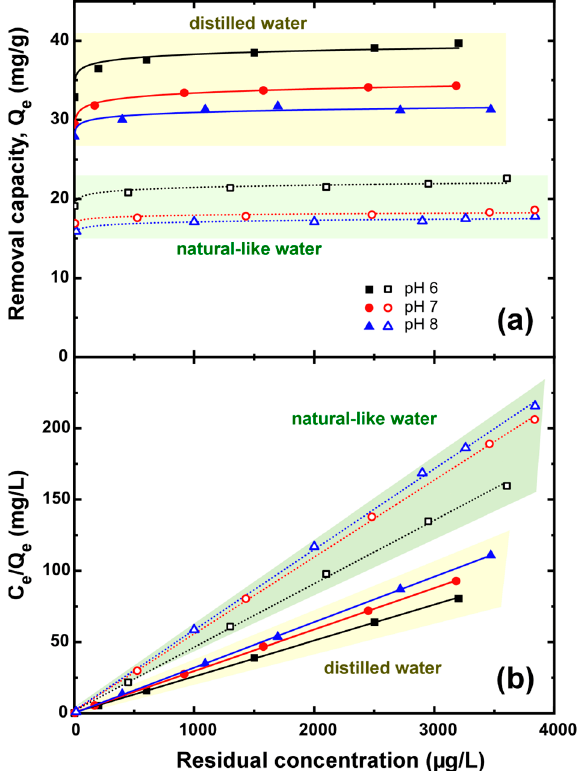
Figure 9. Cr(VI) uptake isotherms of recovered adsorbent from distilled and natural-like water at 20 °C and equilibrium pH 6, 7, and 8, with corresponding fitting by Freundlich ( a ) and Langmuir (linearized) ( b ) equations.